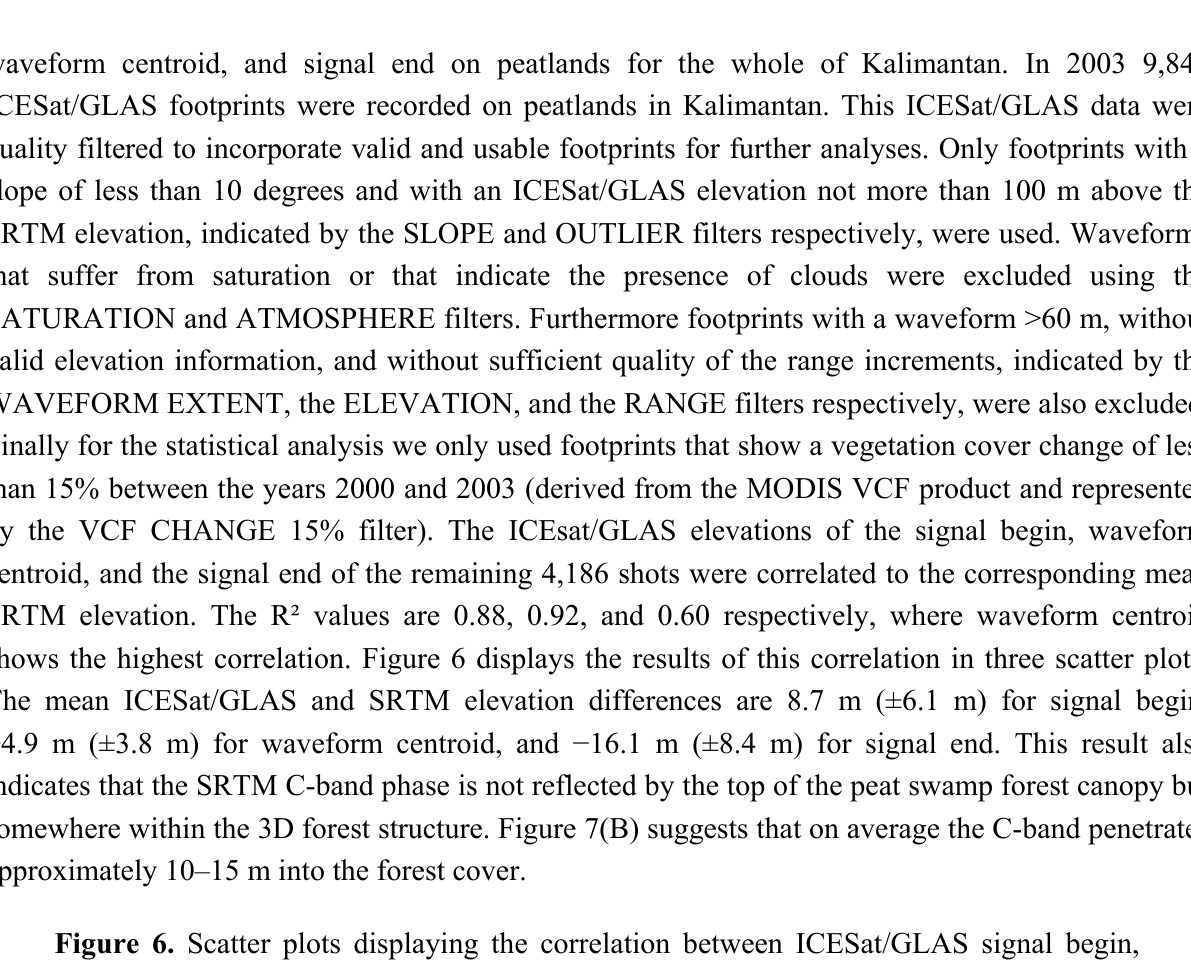
waveform centroid, and signal end elevations a.s.l. (m) to the mean elevation a.s.l. (m) of the corresponding SRTM data. All ICESat/GLAS footprints are from the year 2003 and located on peatlands. The elevation of the waveform centroid with a coefficient of determination (R²) of 0.92 shows the highest correlation to the SRTM